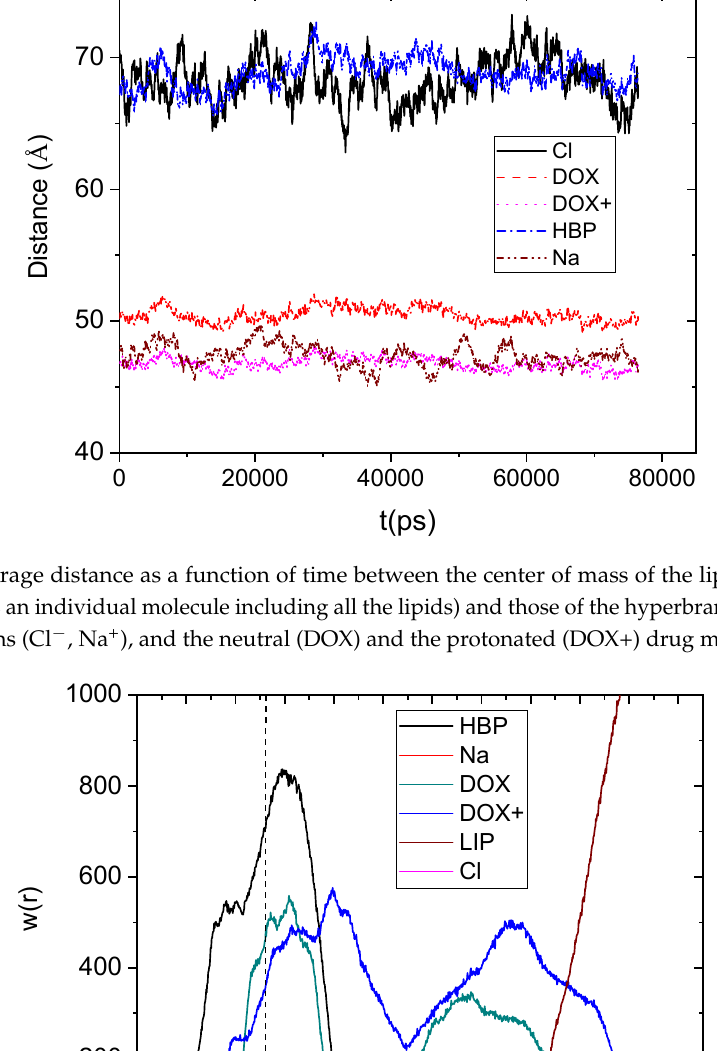
Table 2. Average number and degree of penetration of drug molecules within the HBP’s structure.